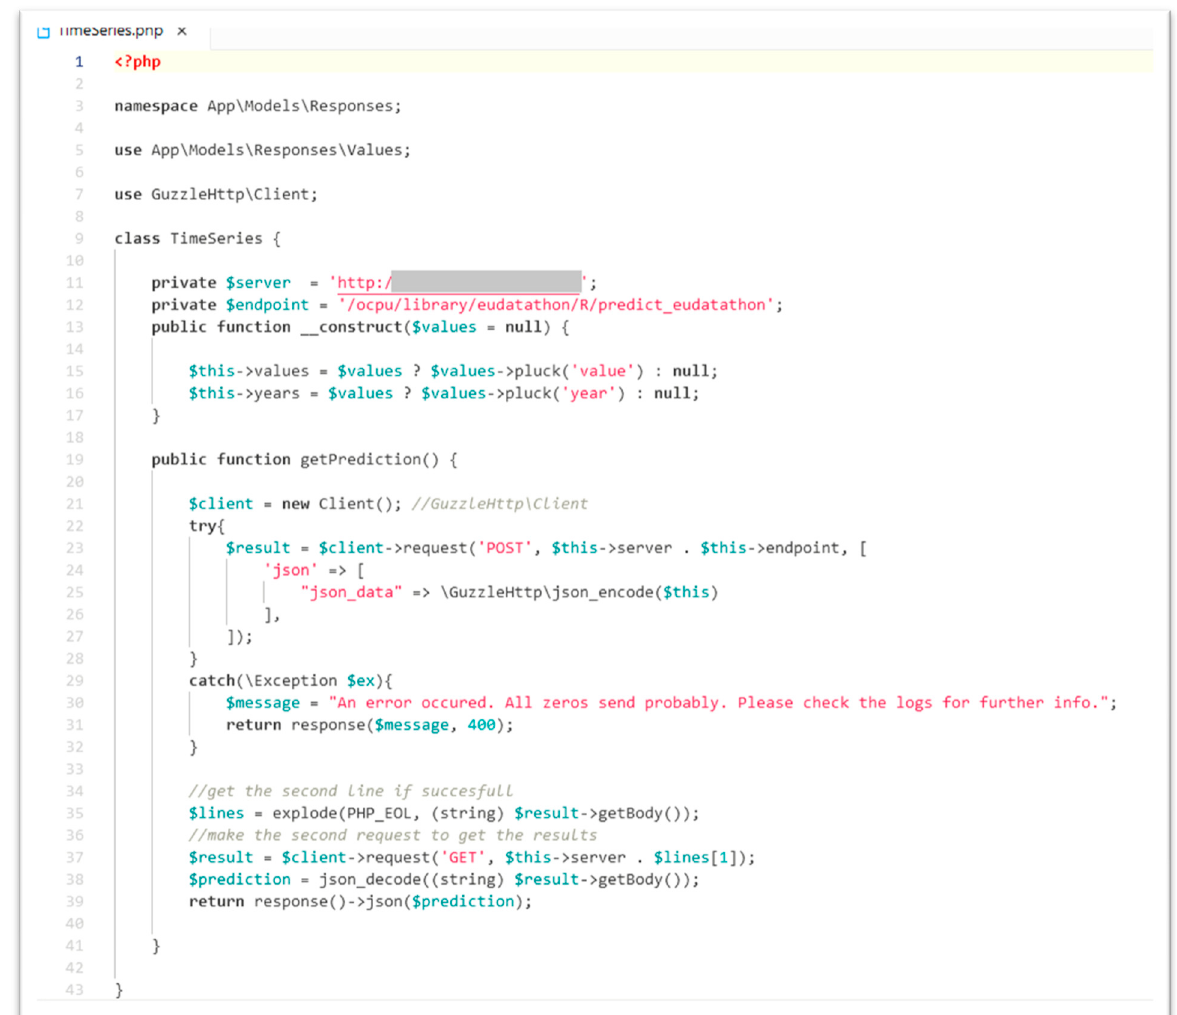
Figure 2. HTTP request to obtain time series